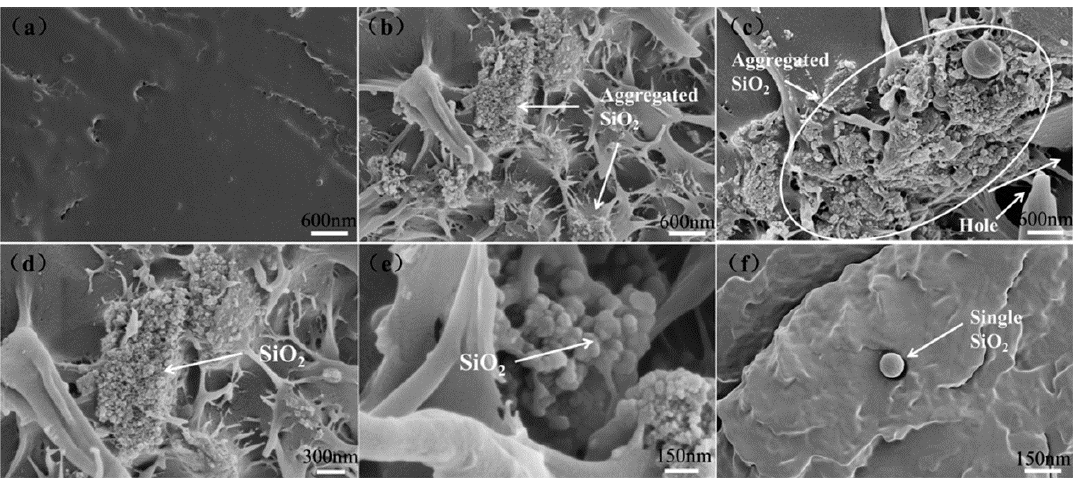
Figure 8. Cross ‐ sectional SEM images of PHBV and RHNS/PHBV composites: ( a ) pure PHBV; ( b ) RHNS/PHBV ‐ 3; ( c ) RHNS/PHBV ‐ 6 and ( d–f ) RHNS morphology of composite at different PHBV-3; ( c ) RHNS/PHBV-6 and ( d–f ) RHNS morphology of composite at different magnifications.